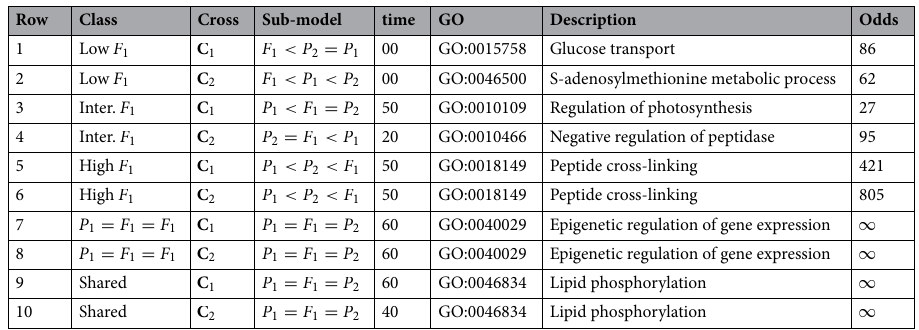
Table 5. Enriched “Biological Process” (BP) with the highest odds per combination of class × cross.